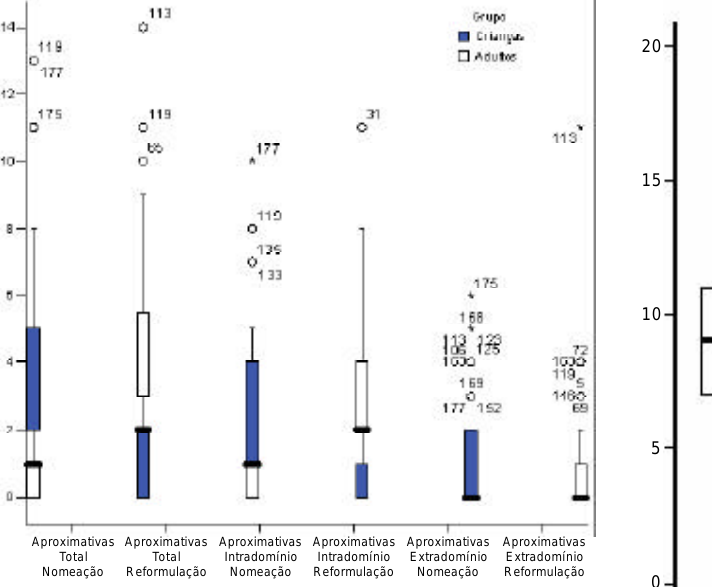
Figura 1 . Freqüência de aproximações do grupo de crianças e de adultos: total, intradomínio e extradomínio nas Tarefas de Nomeação e Reformulação de Ações.